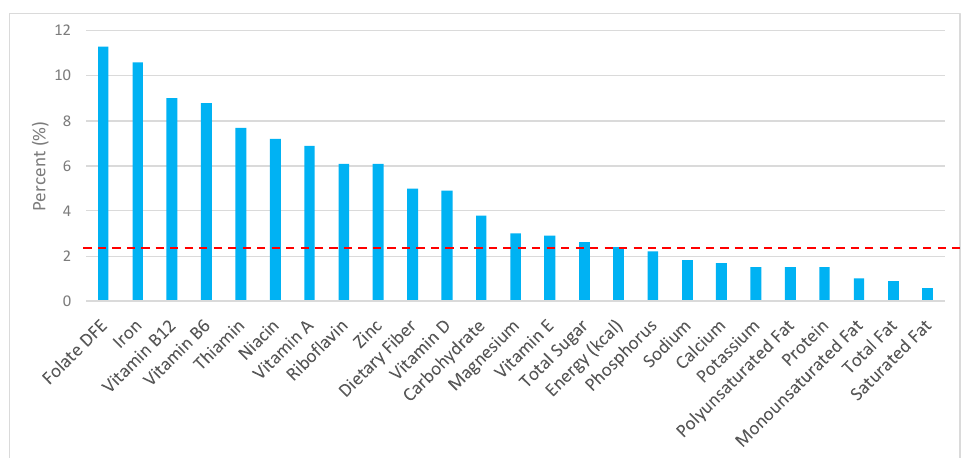
Figure 4. Ready-to-eat cereals as sources of energy and nutrients using NHANES 2009–2012, for adult females. Data are for adult females aged ≥ 19 years of age ( n = 5349), Day 1 intakes; dashed red line represents the percentage of energy provided and nutrients that surpass energy (kcal) contribution.